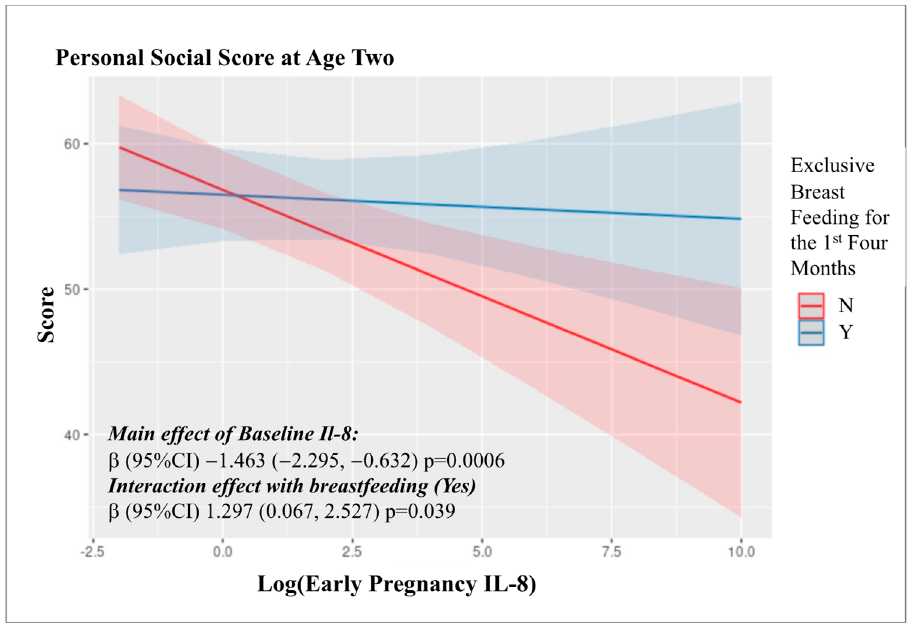
Figure 3. Interaction between log transformed IL8 levels in the first and third trimester and exclusive breast feeding up to four months with Personal-Social skills at Age